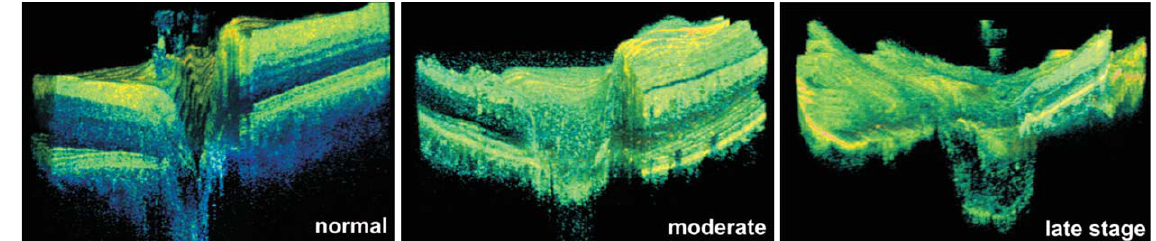
Fig. 3. 3-D visualization of the human retinal nerve fiber layer from a normal optic nerve head (left), intermediate stage glaucoma (middle), and advanced glaucoma (right). The different elevation of the papilla are clearly visible. Figure reprinted with permission from